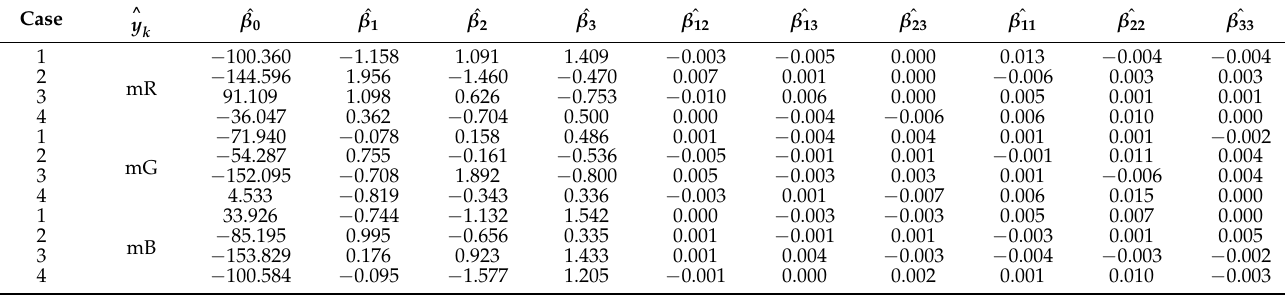
Table A5. Coefficient estimates of the fitted MMR